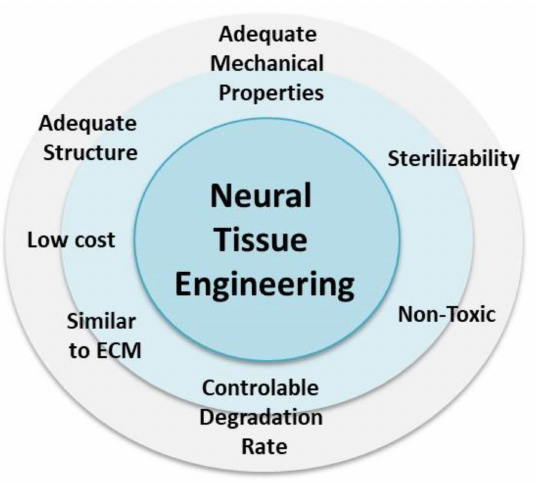
Figure 3. Scaffold requirements for the neural tissue engineering